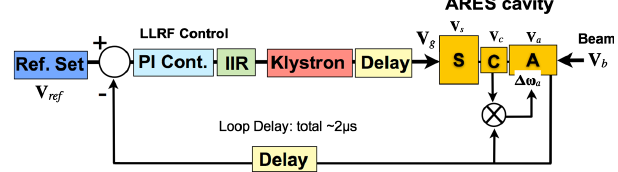
FIG. 3. Implementation of feedback loops in the